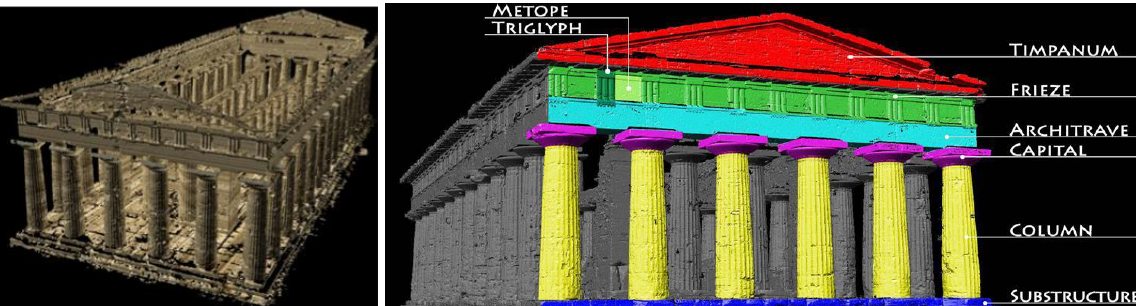
Figure 6: The digitized and textured Neptune temple in Paestum and the classification of its archaeological elements (Fiorillo et al.,